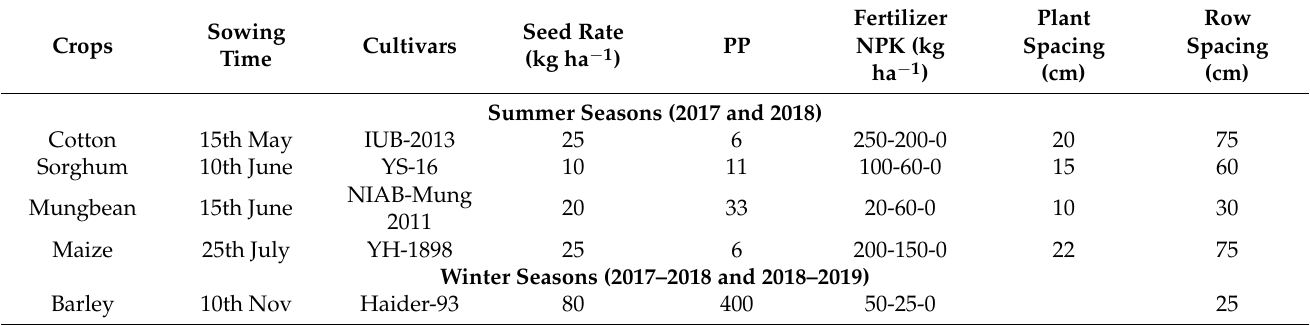
Row Fertilizer Plant Spacing Spacing PP